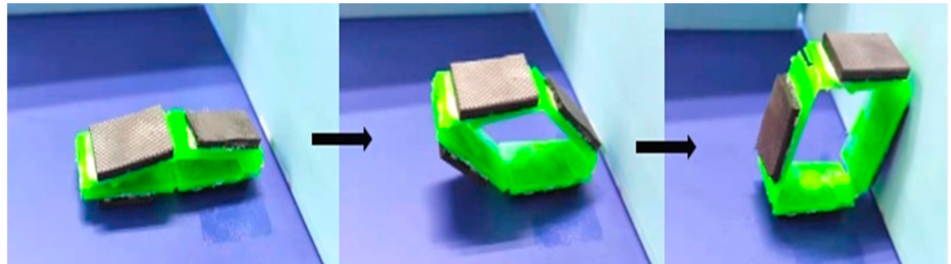
Figure 8. Magnetically driven rhombic deformations of soft actuator.